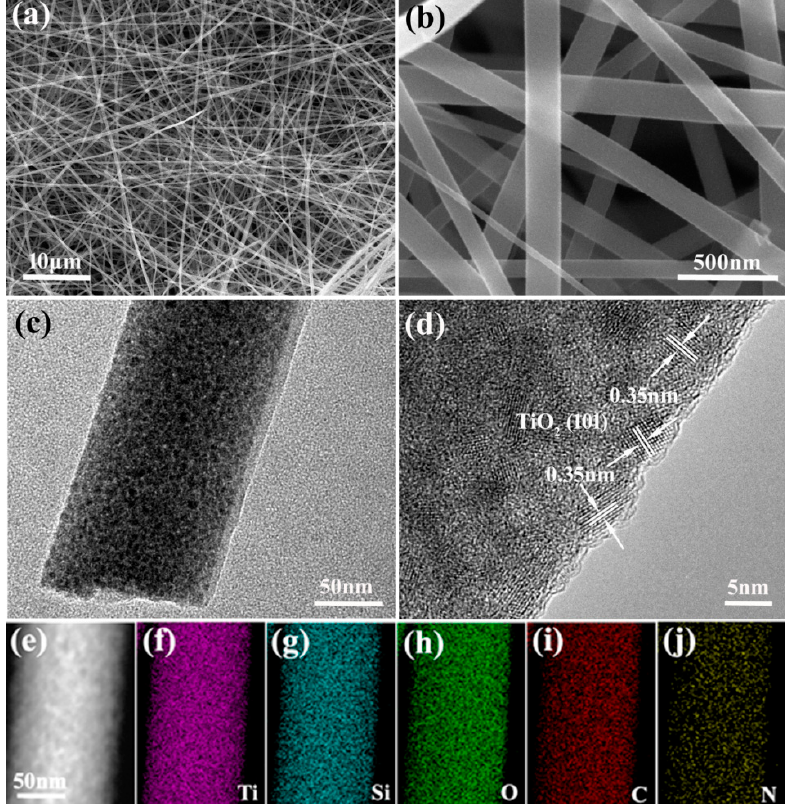
Figure 2. ( a , b ) SEM images, ( c ) TEM and ( d ) HRTEM images of TSC nanofibers. ( e ) HAADF-STEM image of a single TSC nanofiber with corresponding EDS maps of ( f ) Ti, ( g ) Si, ( h ) O, ( i ) C and ( j ) N elements.